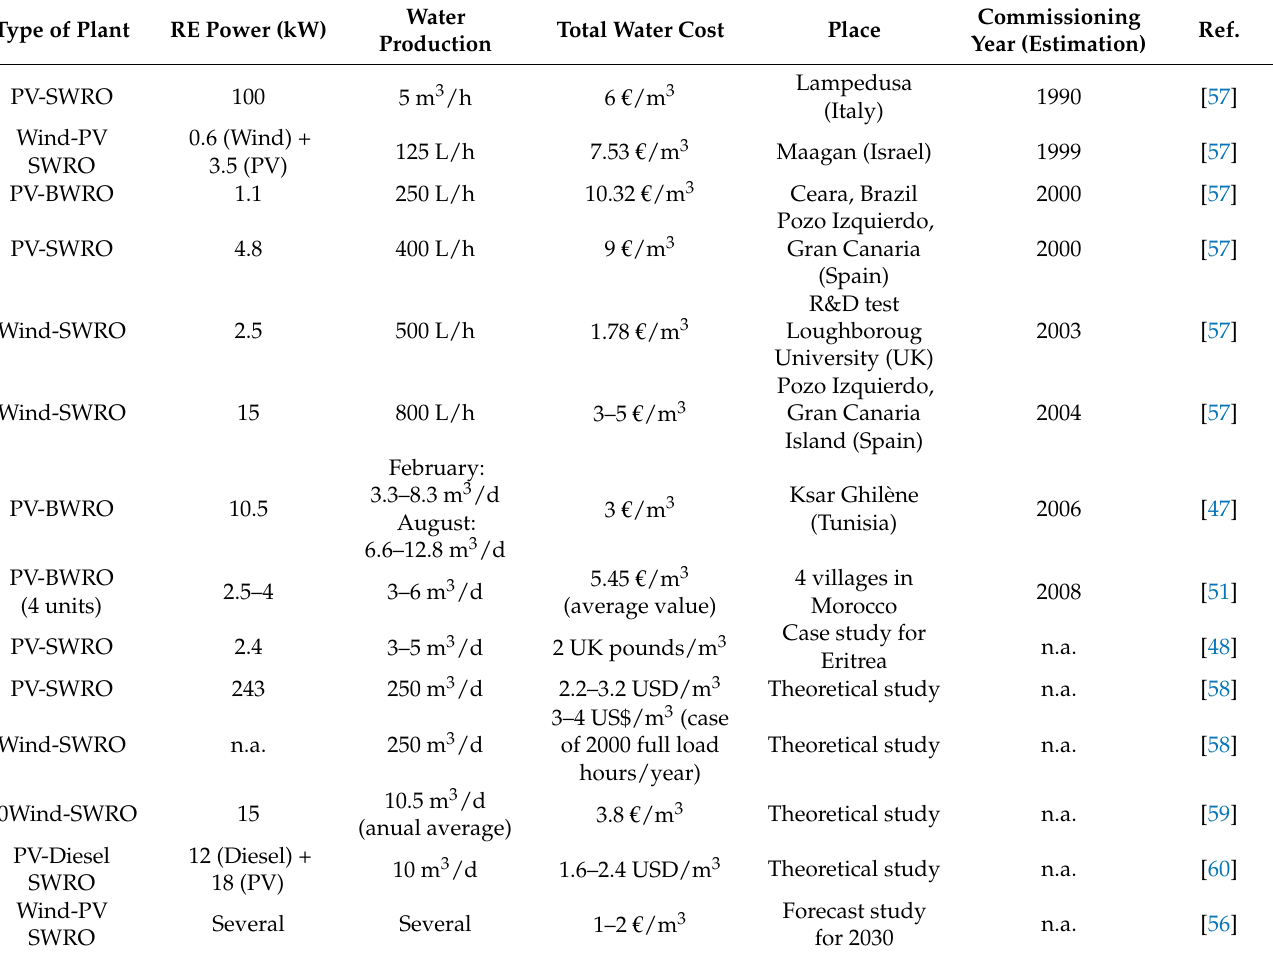
Table 14. Selection of the main data and water costs of different